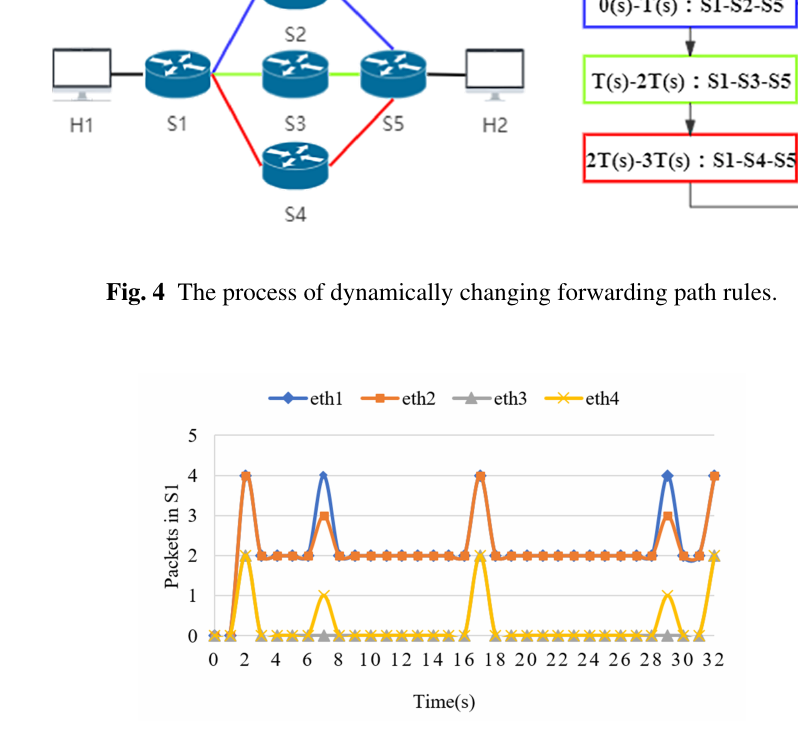
Fig. 5 The number of packets in S1 without load